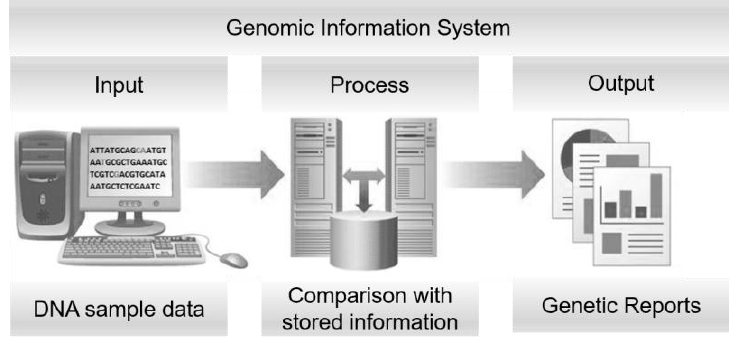
Figure 9. Architecture of a Genomic Information System (GeIS) for genetic